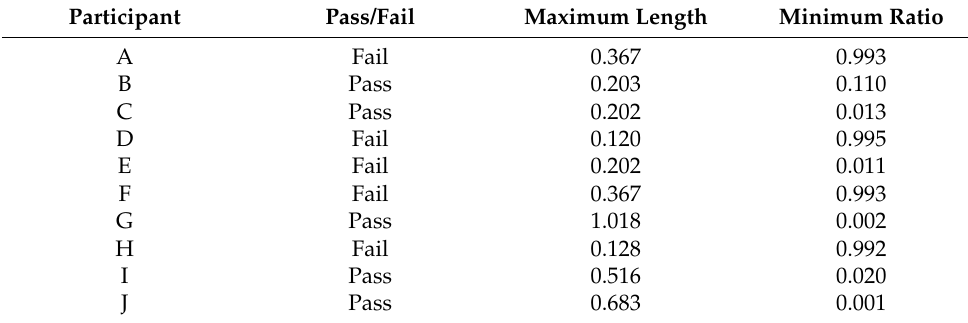
Figure 9. A mechanical assembly designed by one of the participants in our experiment. The white and yellow trajectories represent the straightest and longest movements obtained from this structure, respectively. Table 2. Performance data obtained from the participants in our